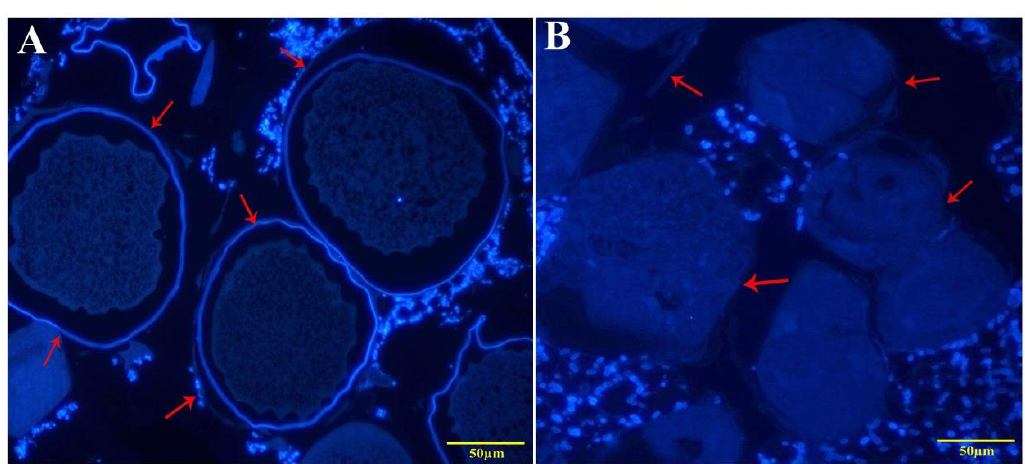
Figure 10. Hematoxylin and eosin staining of adult mites from the ( A ) (control gene dsRNA- egfp ) and ( B ) (target gene dsRNA- PcCHS1 ) treatment groups. CUT stands for cuticle; EPI stands for epidermis; FB stands for fat bodies; and MUS stands for muscles. CUT and FB indicate cuticle and fat bodies, bodies, respectively. respectively.